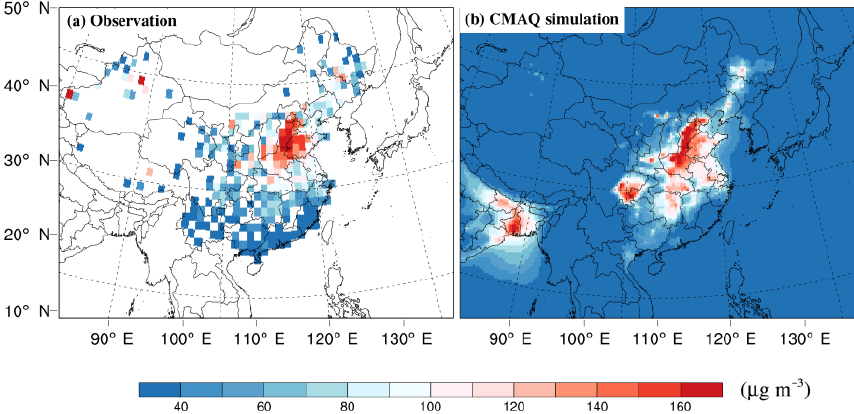
Figure 5. Spatial distributions of monthly mean PM 2 . 5 concentration in December 2015 for observations (a) and CMAQ simulation (b) . Please note that the label bar starts from 40µgm − 3 instead of 0 in order to aid easy viewing of the comparison. Table 1. Evaluation of WRF performance over North China (nine stations) ∗